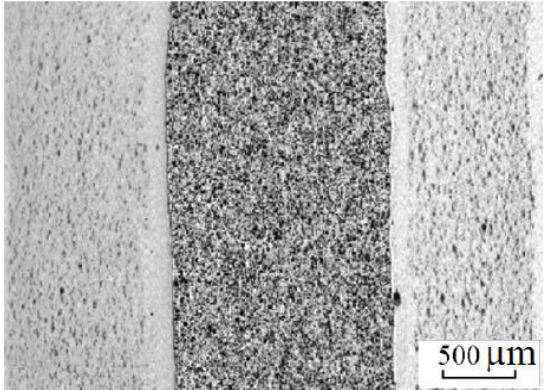
C-TiB /TiN-35AlN composite. 4 2